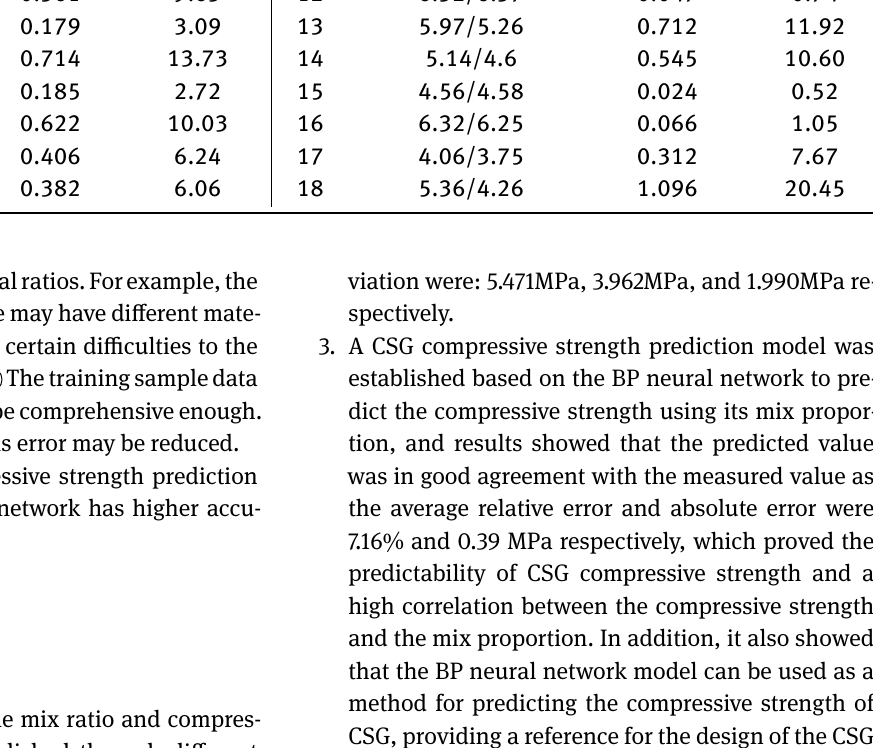
Table 5: Error table of 28d compressive strength SN Measured value/ Predicted value (MPa)